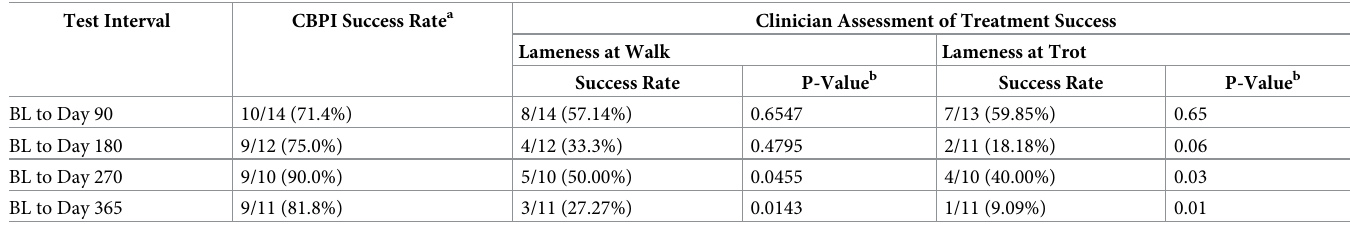
Table 4. Comparison of Canine Brief Pain Inventory (CBPI) assessment by dog owners and clinician assessment of treatment success following administration of tin-117m colloid. Test